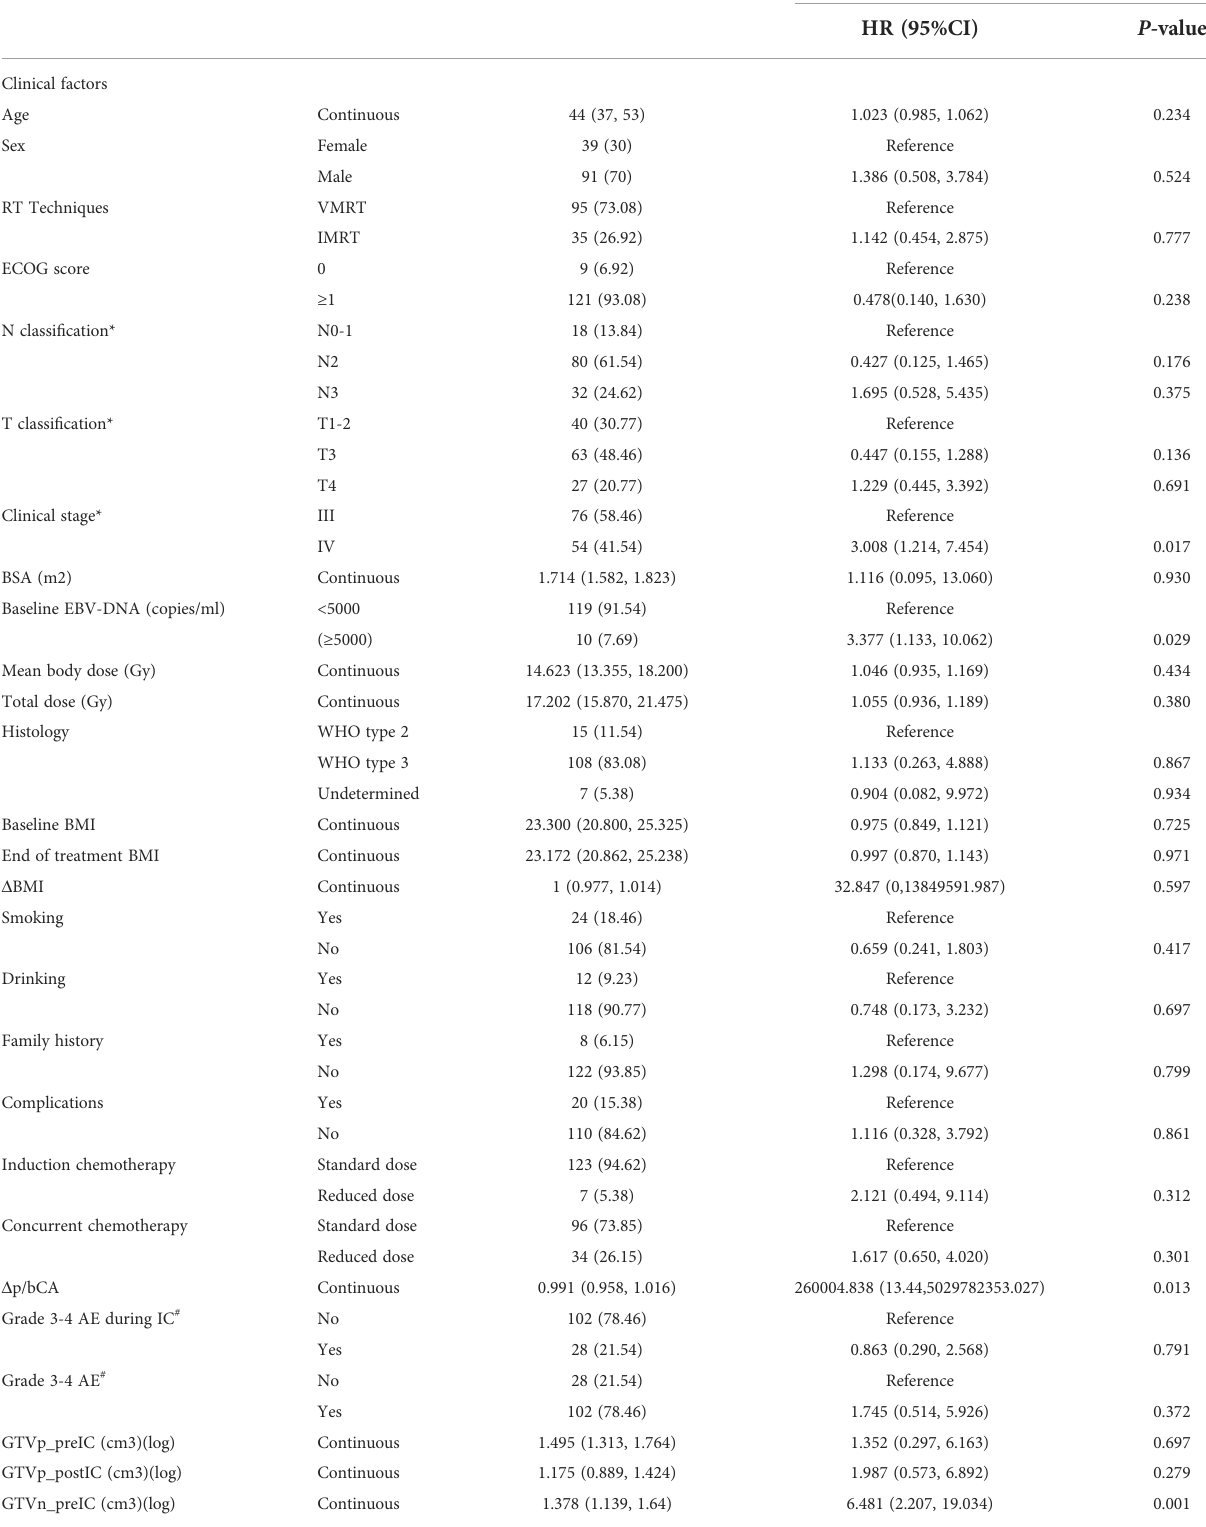
TABLE 1 Patient characteristics and univariate